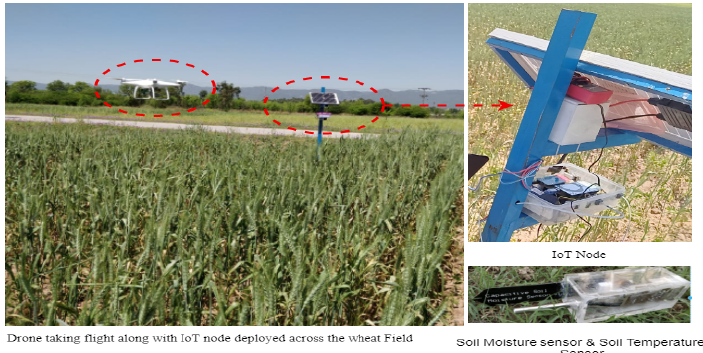
Figure 4. System deployed across the wheat fields.